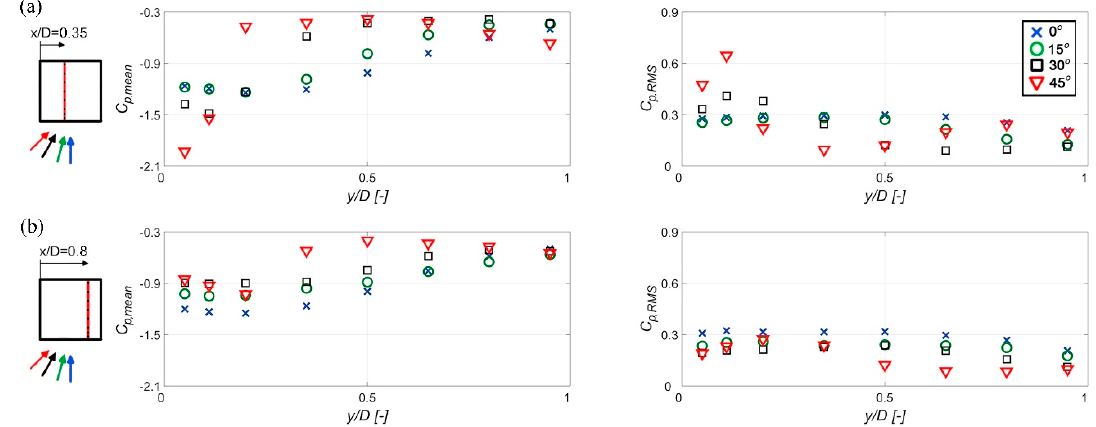
Figure 7. Mean ( C p mean ) and standard deviation ( C p RMS ) distributions of the surface pressure coefficient for different wind angles, 0°, 15°, 30° and 45°, along different alignments on the roof: ( a ) x/D = 0.35, ( b ) x/D = 0.8.